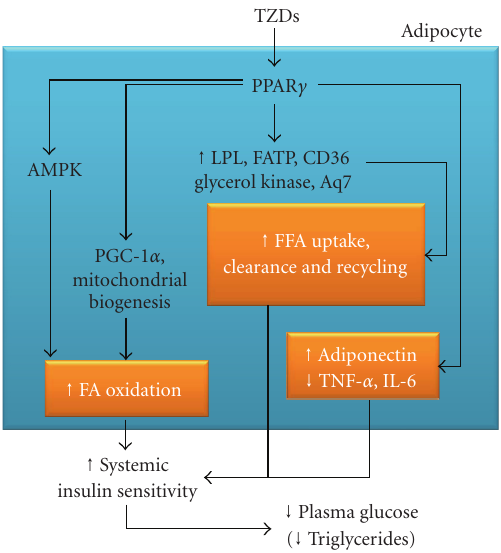
Figure 4: Cellular e ff ects of PPAR γ activation in adipocytes. TZDs improve whole-body insulin sensitivity by modulating glucose and lipid metabolism in adipose tissue as well as adipokine secretion by adipocytes. FA: fatty